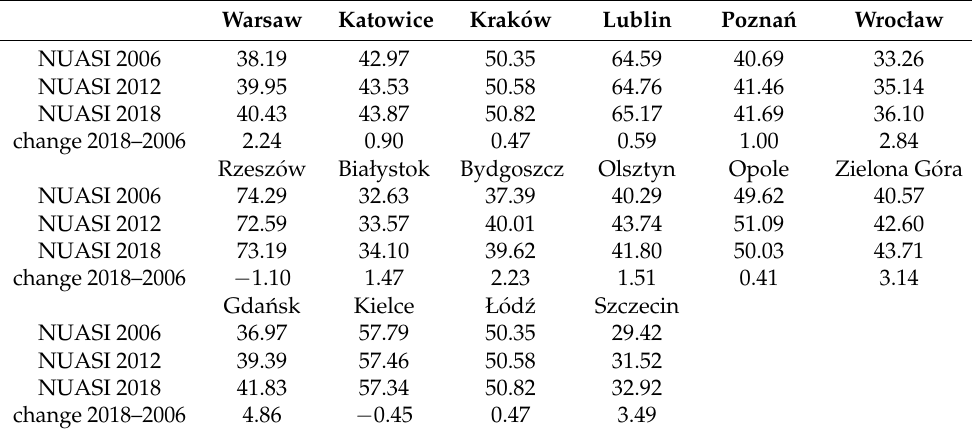
Table 6. NUASI [%] for 2006, 2012, and 2018 and changes from 2006 to 2018 for all